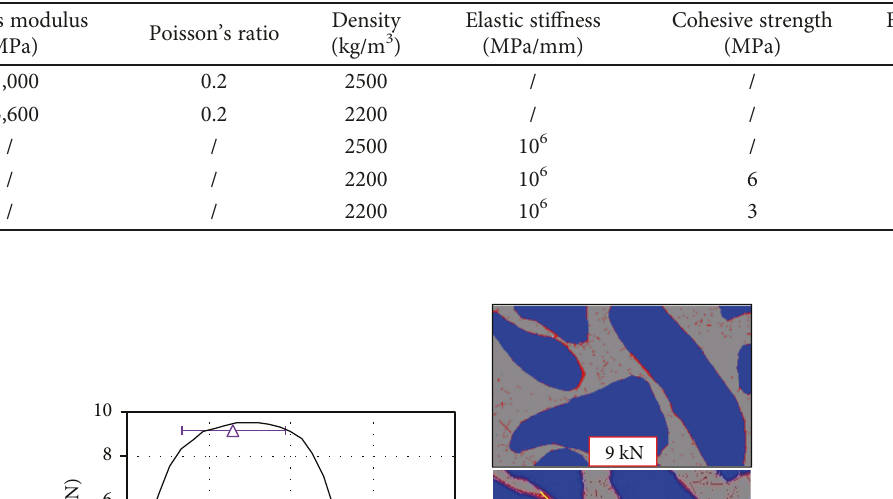
Table 5: Material properties.